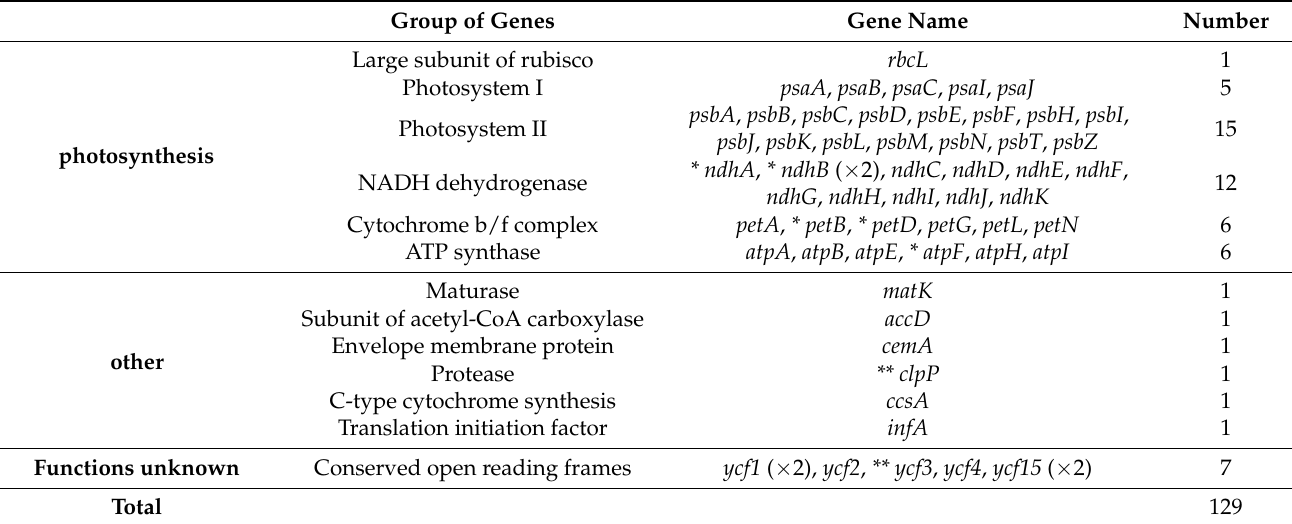
Table 1. Cont. Group of Genes